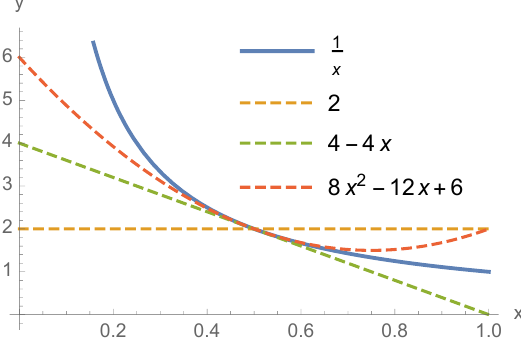
Figure 2. The first three Taylor expansions of y = 1 The zeroth order Taylor expansion, 1/ x ≈ 2, corresponds to the case of equal cluster